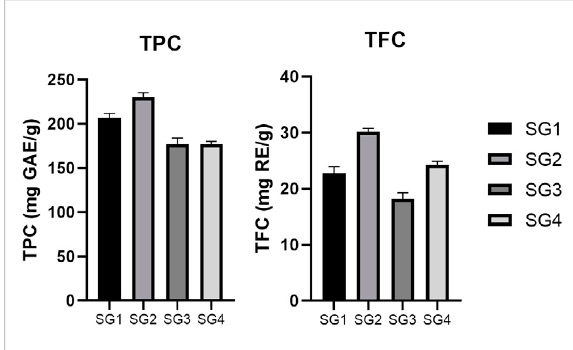
FIGURE 2 Comparison between total phenolic content (TPC) and total fl avonoid content (TFC) determined for the SG samples. The results are expressed as relative means ± standard deviation of three parallel